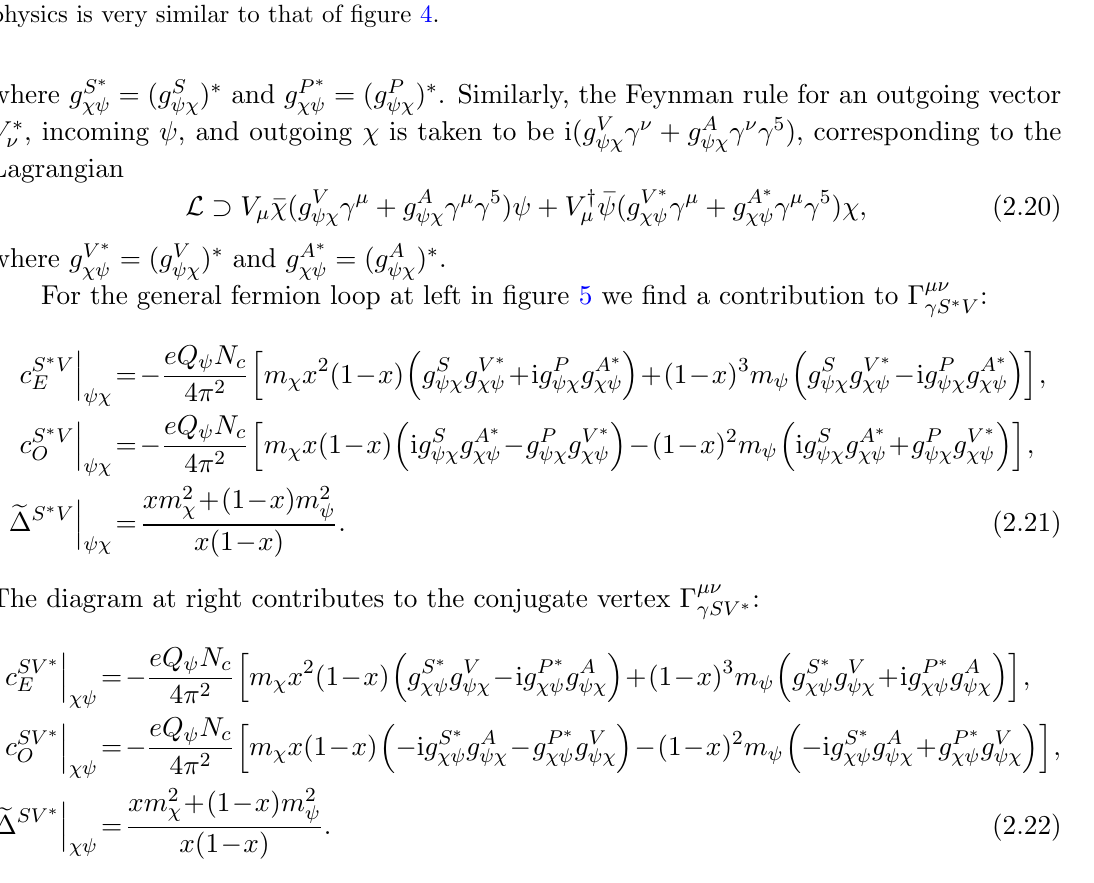
Figure 5 . Fermions and (cid:31) running in the inner loop to produce an e(cid:11)ective (cid:13)S (cid:3) V vertex. The physics is very similar to that of (cid:12)gure